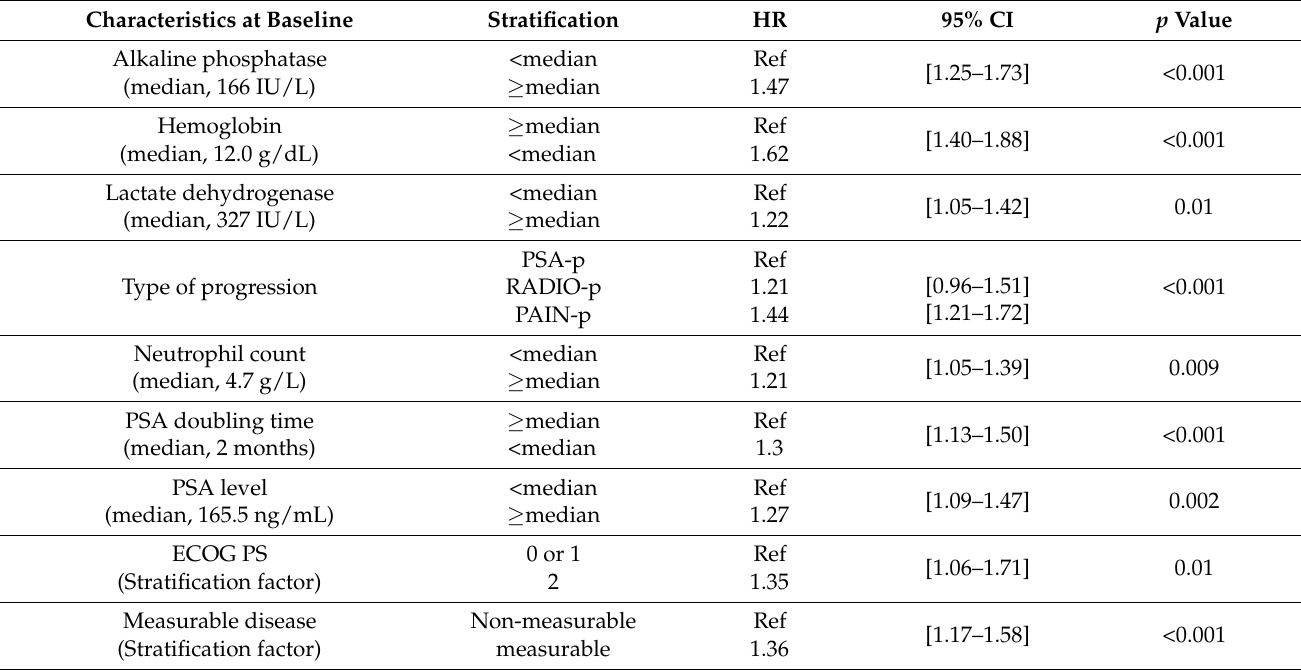
Table 2. Multivariate analysis of overall